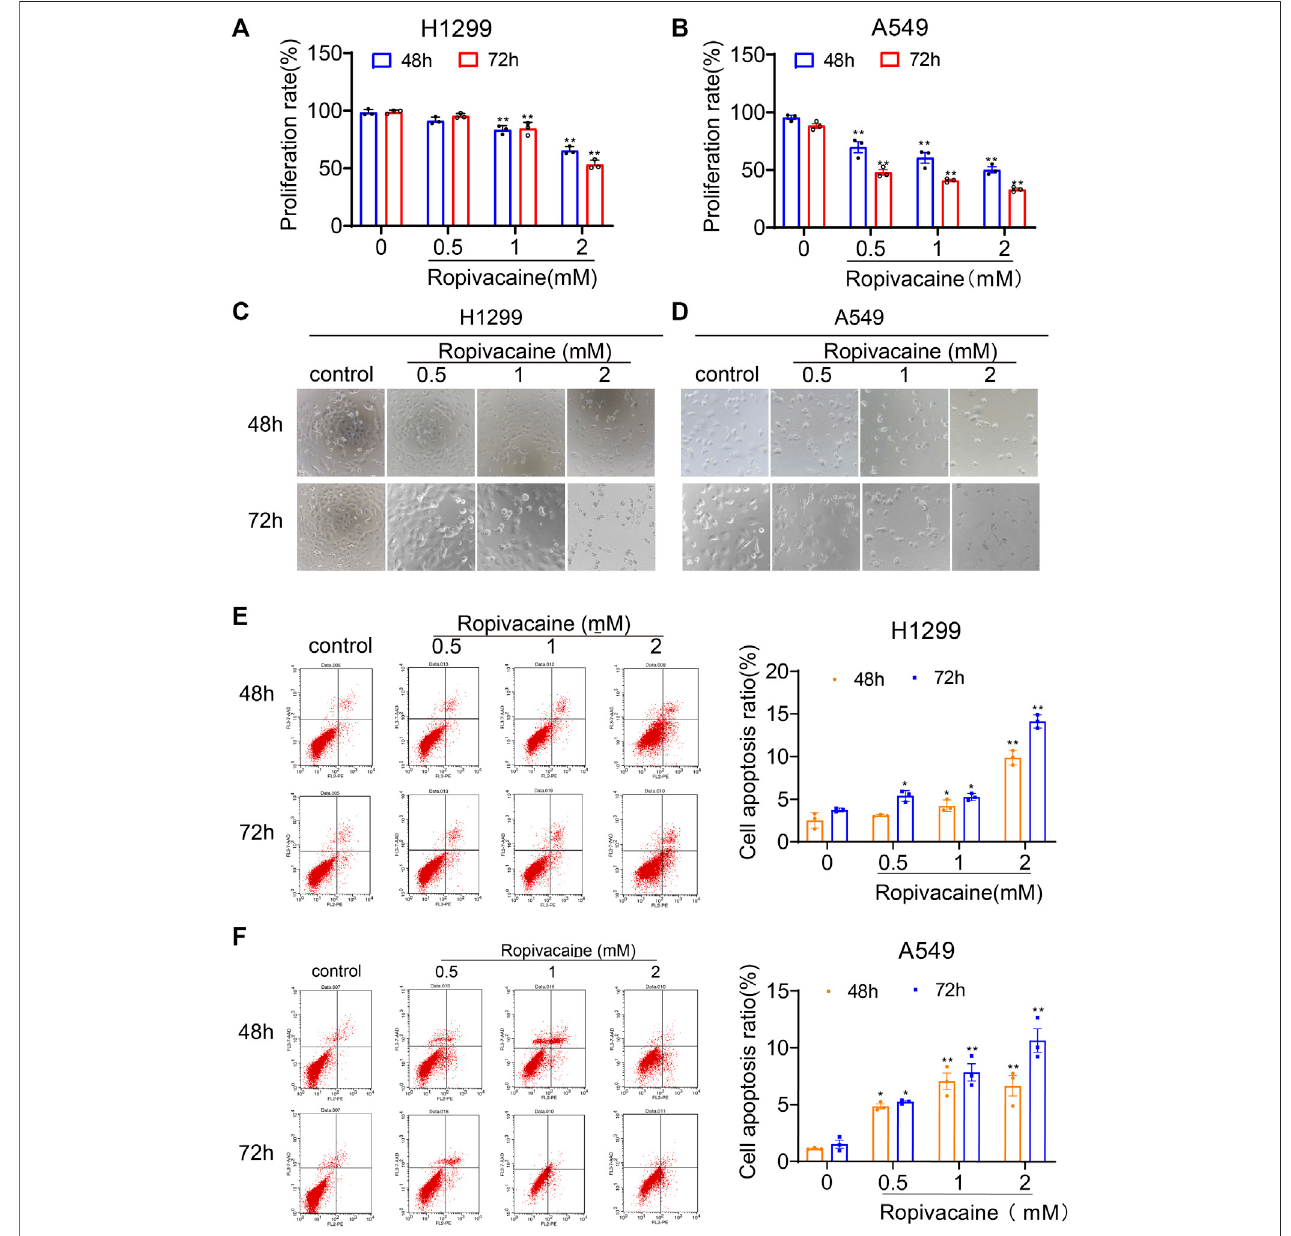
FIGURE 1 | Ropivacaine inhibited proliferation and promoted apoptosis of lung cancer cells. H1299 (A) and A549 (B) cells treated with ropivacaine (0.5, 1, and 2 mM)for48or72 h.MorphologicalchangesofH1299 (C) andA549 (D) cellstreatedwithropivacainefor48or72 h.ApoptoticdeathoflungcancerH1299cells (E) and A549 cells (F) measured by fl ow cytometry analysis following a 48 or 72 h treatment. Independent experiments were repeated three times. Data are presented as the mean ± SD. * p < 0.05 and ** p < 0.01 vs. the control